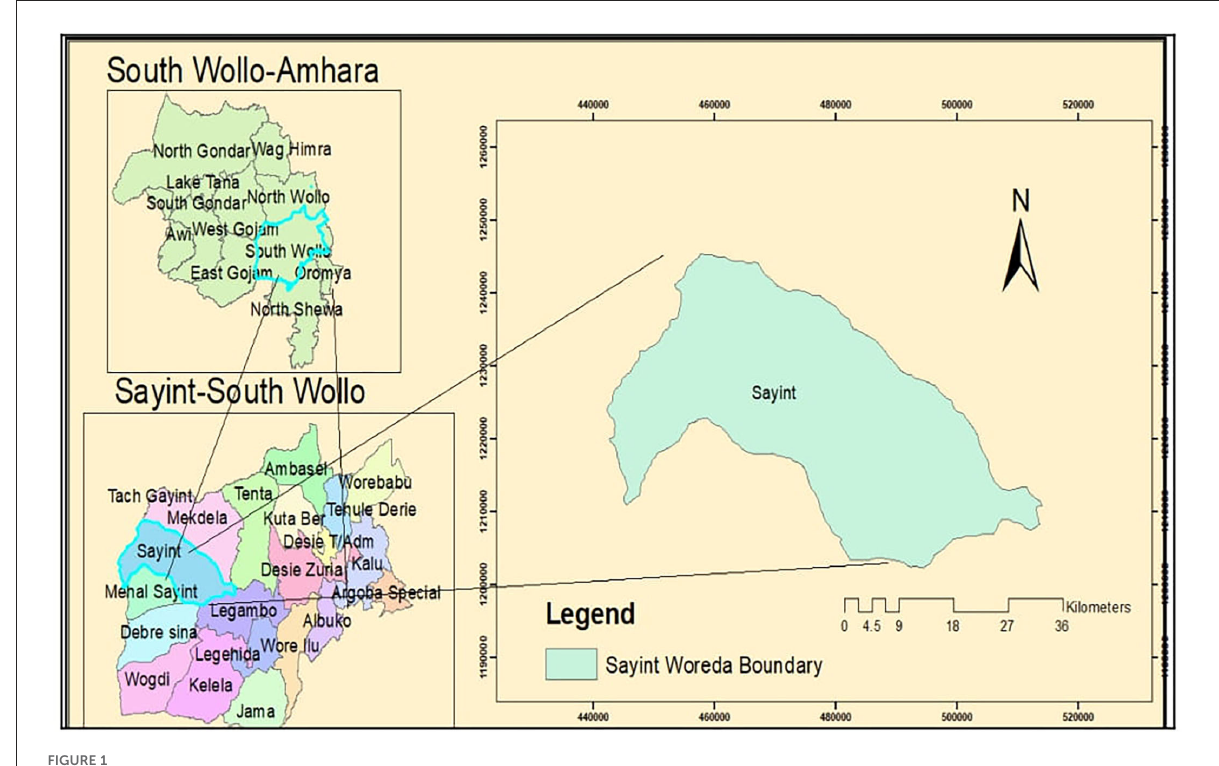
FIGURE1 Location map of the study